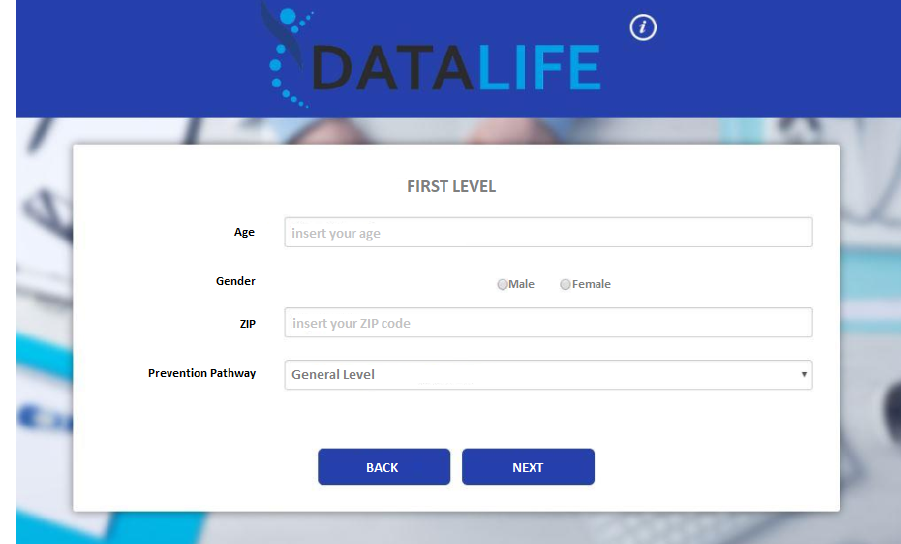
Figure 7. Layout of the deployed web application: Interface asking for the preliminary